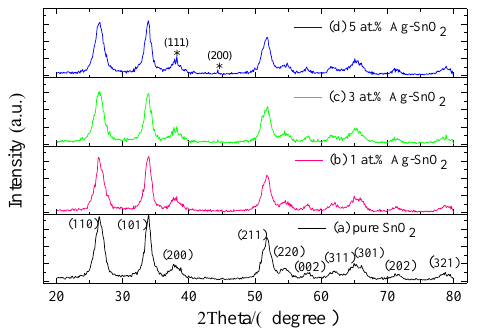
Figure 2. XRD patterns of pure and 1 at.%, 3 at.%, 5 at.% Ag-doped SnO 2 .